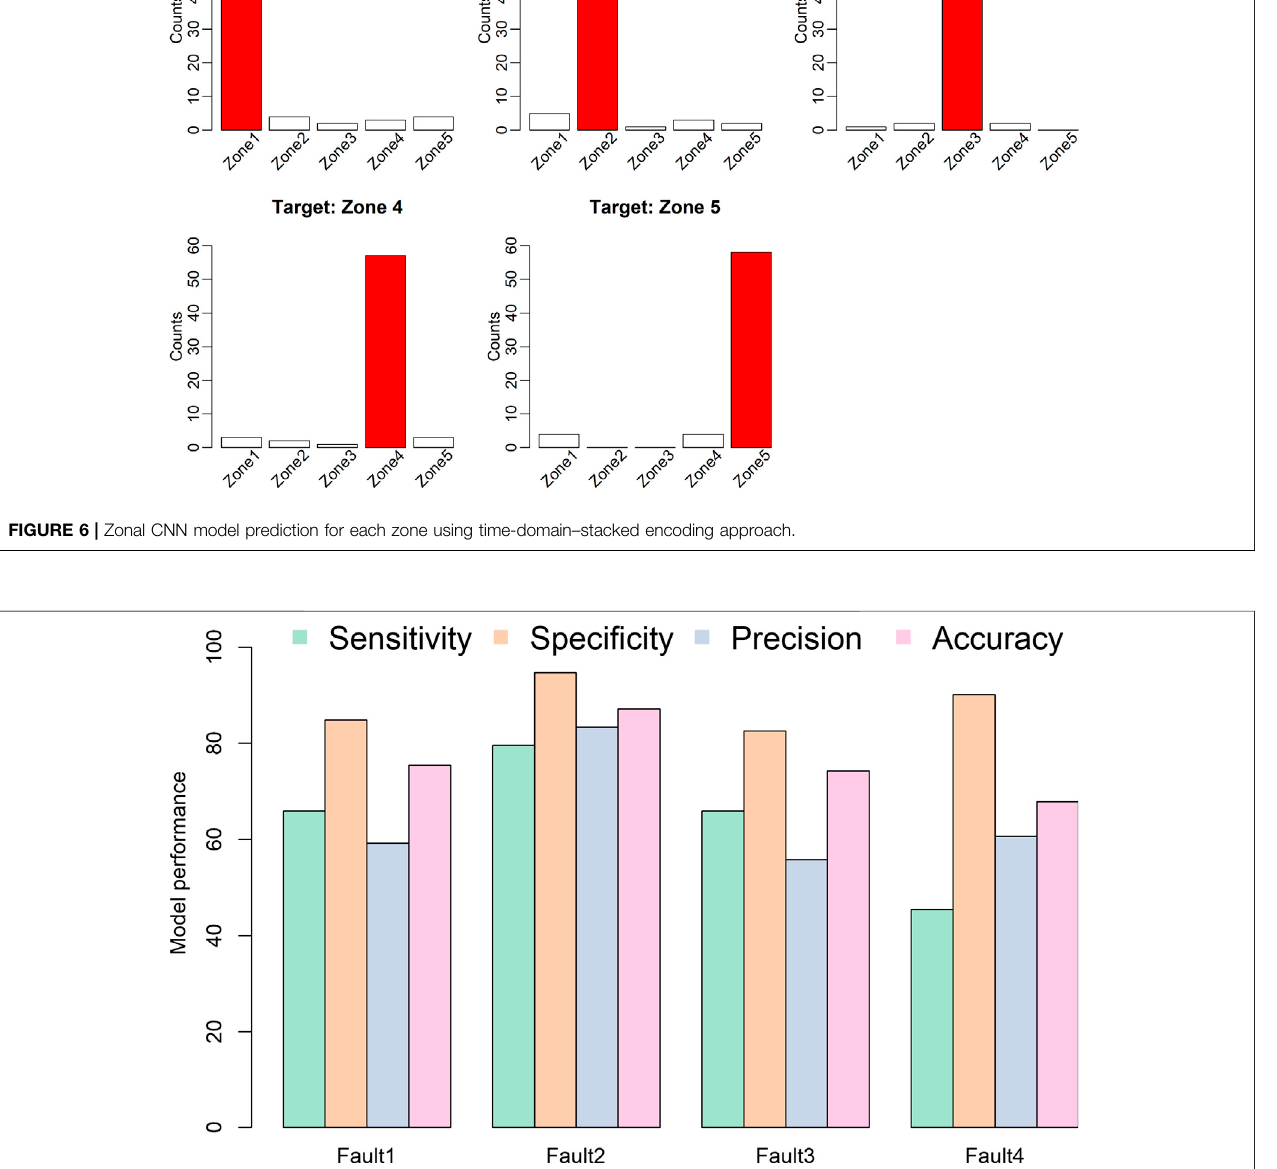
FIGURE 7 | Fault type CNN model performance confusion metric using time-domain – stacked encoding